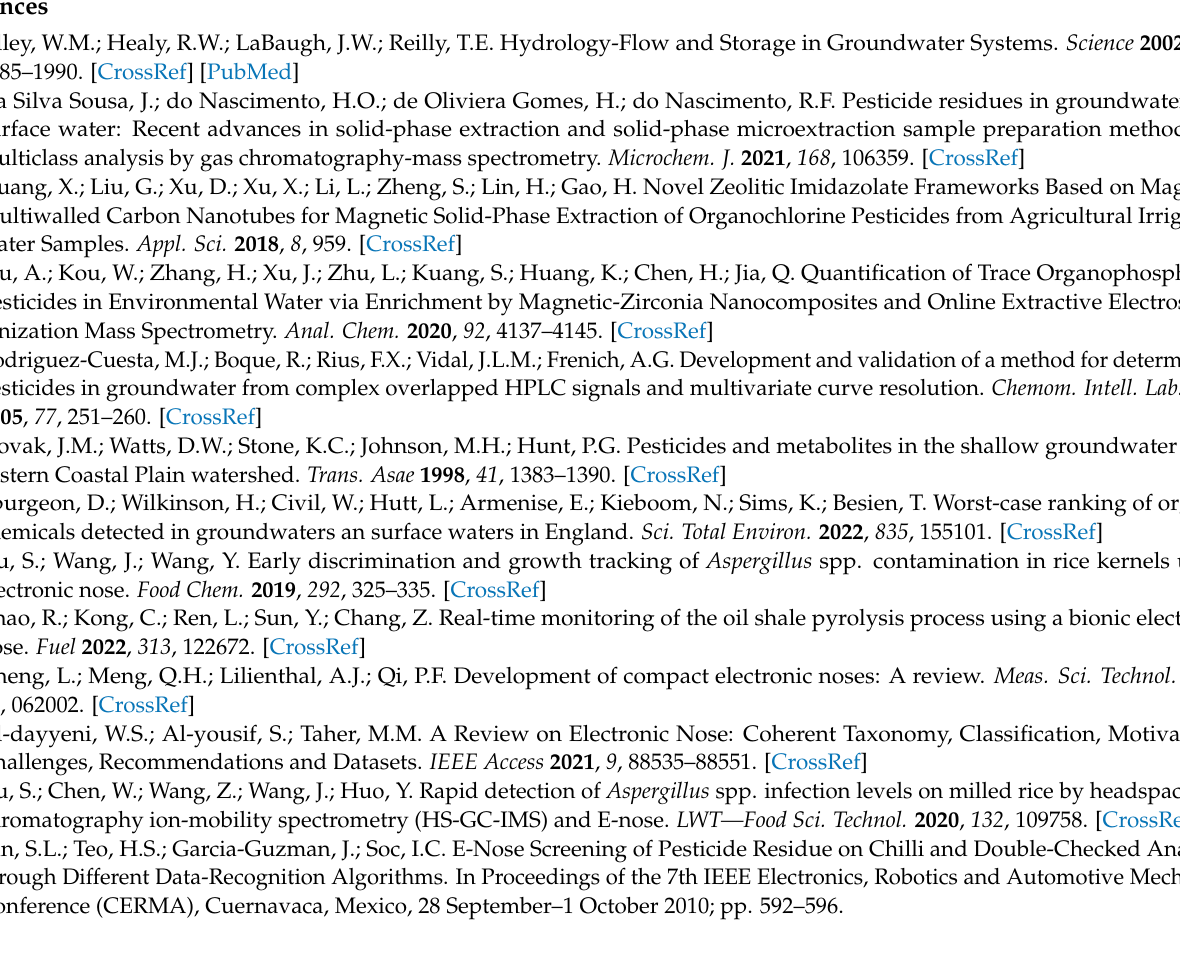
Table S3: Properties of gas sensors chosen in the e-nose